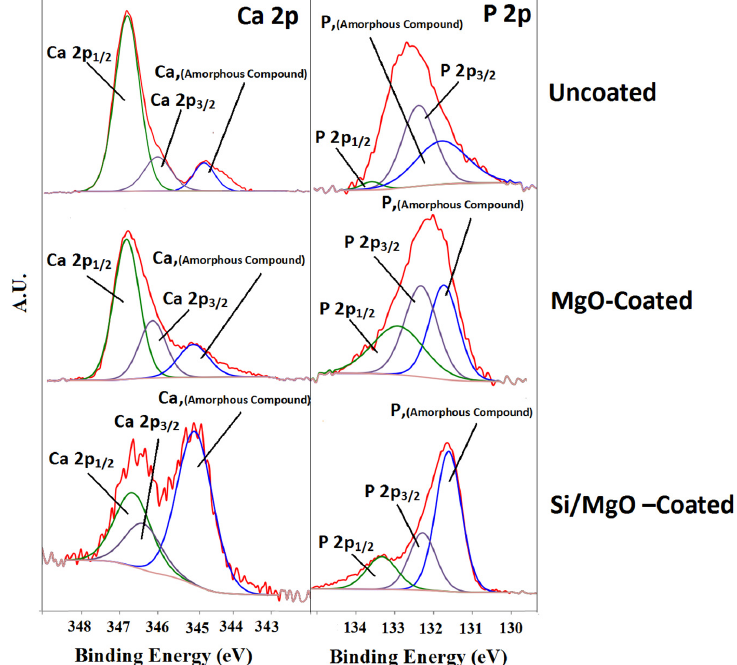
Figure 13. Detailed XPS spectra of the P 2p and Ca 2p peaks of uncoated, MgO ‐ coated and Si/MgO ‐ coated after 7 days of immersion in a SBF solution at 37 °C.